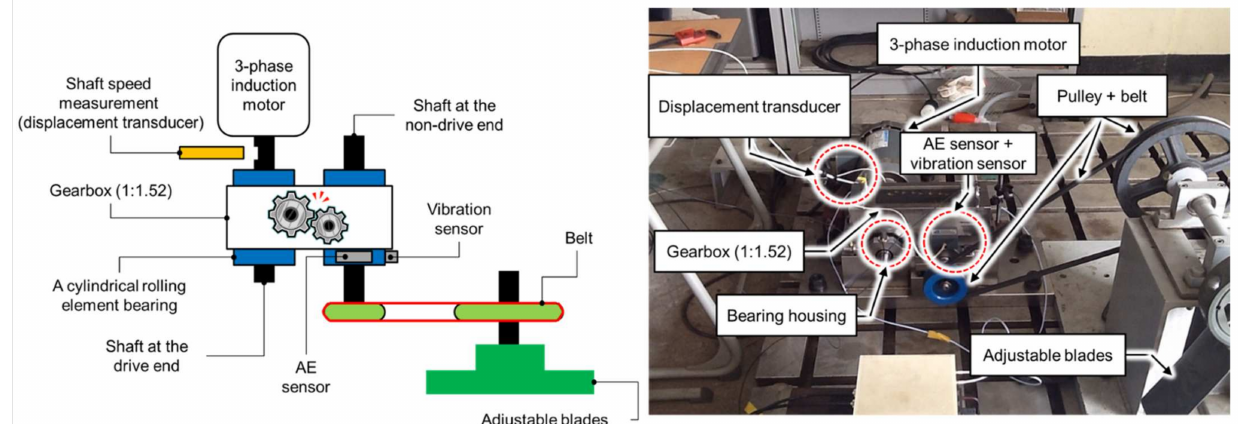
Figure 6. Self-designed testbed for collecting vibration signals.